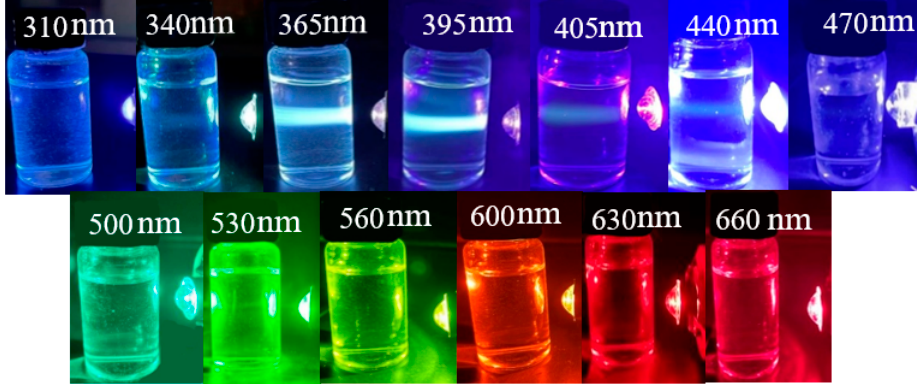
Figure 2. Phenomena of liquor under different wavelengths of light.